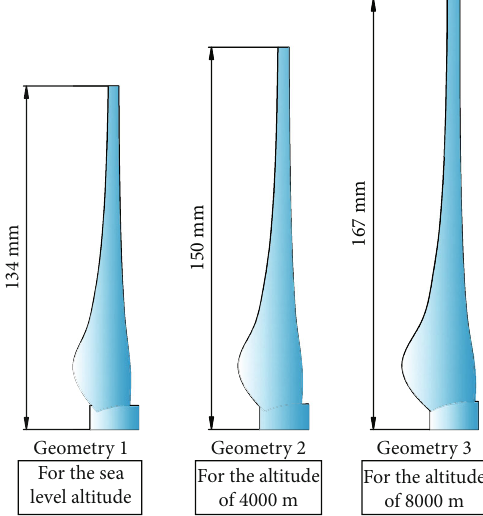
Figure 4: The geometry of blade for 3 di ff erent altitudes for the same thrust generation 3.35 N.